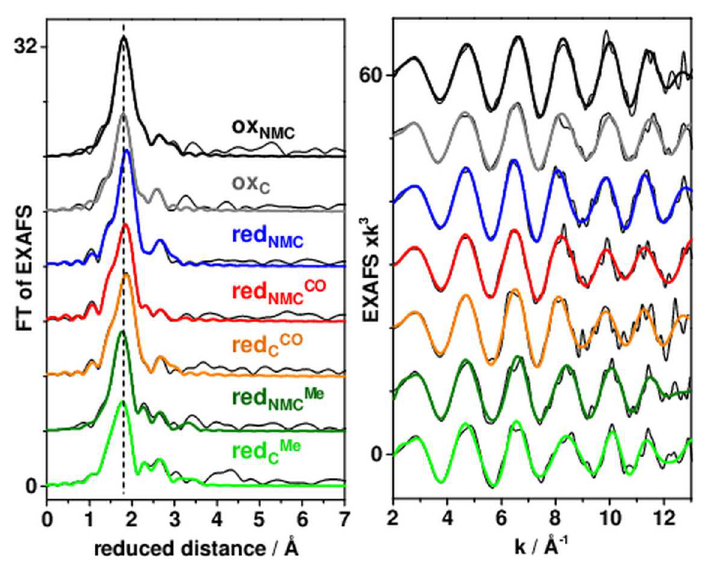
Fig 3. EXAFS analysis of ACS Ch . Thin black lines, experimental data (vertically shifted for comparison); thick (colored)lines, simulationcurves with parameters in Table 2 (secondfits). Vertical dashes highlightthe Fourier-transform (FT) main peak